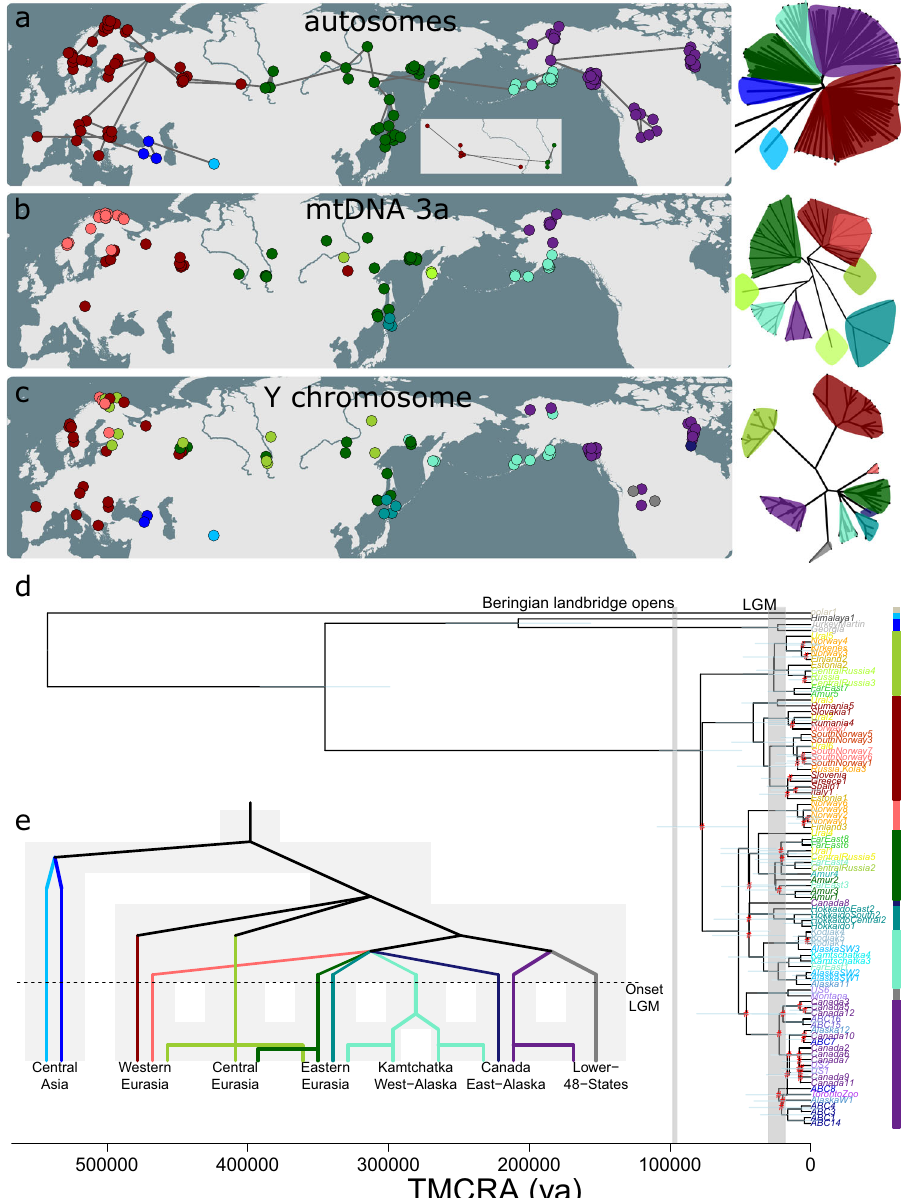
Fig. 2 Spatial distribution of genetic clusters, depicting the (in)consistencies between markers, possibly partly caused by incomplete lineage sorting. Geographical distribution of individuals, with colour coding according to genetic cluster instead of population assignment. a Geographical map showing hierarchical clustering (using bioNJ method) of brown bear individuals based on Euclidean distances for autosomal SNP data. Lines connecting samples represent a minimum spanning tree (generated with the function ‘ mst ’ of the R-package ‘ ape ’ ), based on allele sharing distances. Inset: detail of minimum spanning tree in central Russia, which highlights that the transition in western Siberia between the western (red) and eastern (darkgreen) Eurasian clades is abrupt rather than gradual. b Geographical map showing the distribution of variants of mtDNA haplotype clade 3a, according to a maximum likelihood phylogeny generated with the software IQtree. c Geographical map showing the distribution of Y chromosome haplotypes (see d). d Rooted Y-chromosomal maximum-likelihood phylogeny, generated with the software IQtree. The phylogeny has been linearised using the mean path length method, and branch lengths have been converted in TMCRA-estimates assuming a mutation rate of 1.3 ×10 − 9 per site per year. Lightblue bars indicate con fi dence intervals of the node ages. Nodes with ultrafast bootstrap support values below 0.95 are highlighted in red. The colour bar on the righthand side corresponds to the genetic clusters in Fig. 2c. The tip colour coding (sample names) corresponds to population assignment as in Fig. 1. e Speculative model on Y-chromosomal phylogeography, with background grey shaded areas depicting population connectivity. Colours correspond to genetic clusters in Fig.